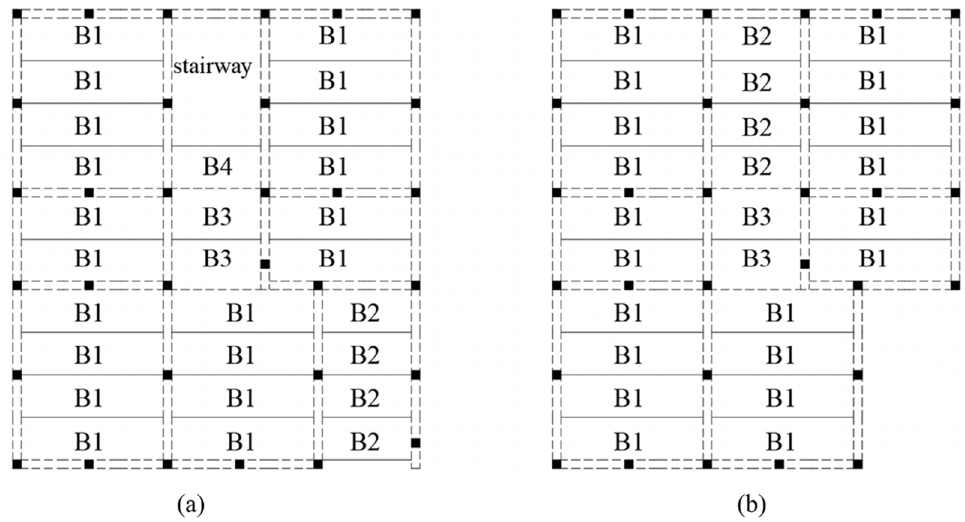
Figure 9. Layouts of composite slabs: ( a ) first floor and ( b ) second floor.